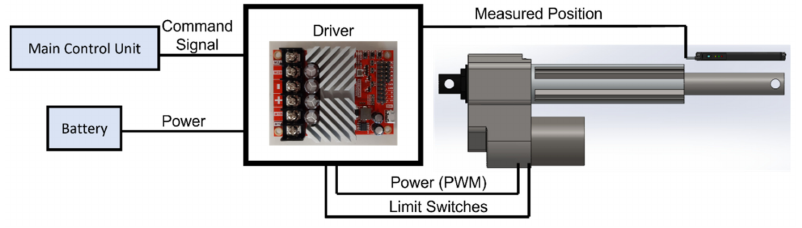
Figure 14. Control